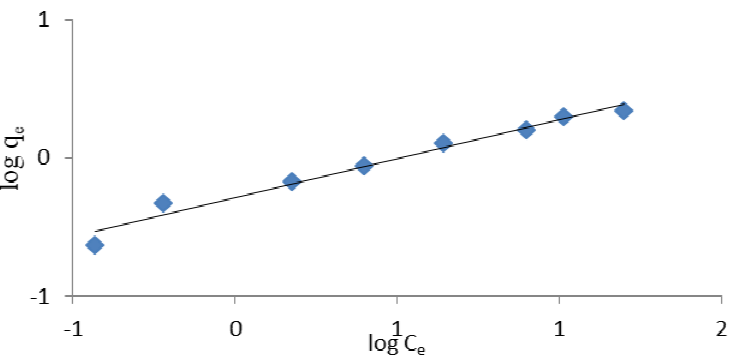
Figure 3. Freundlich linearised isotherm for the removal of ammonium ions from NH 4 Cl solution in distilled water.